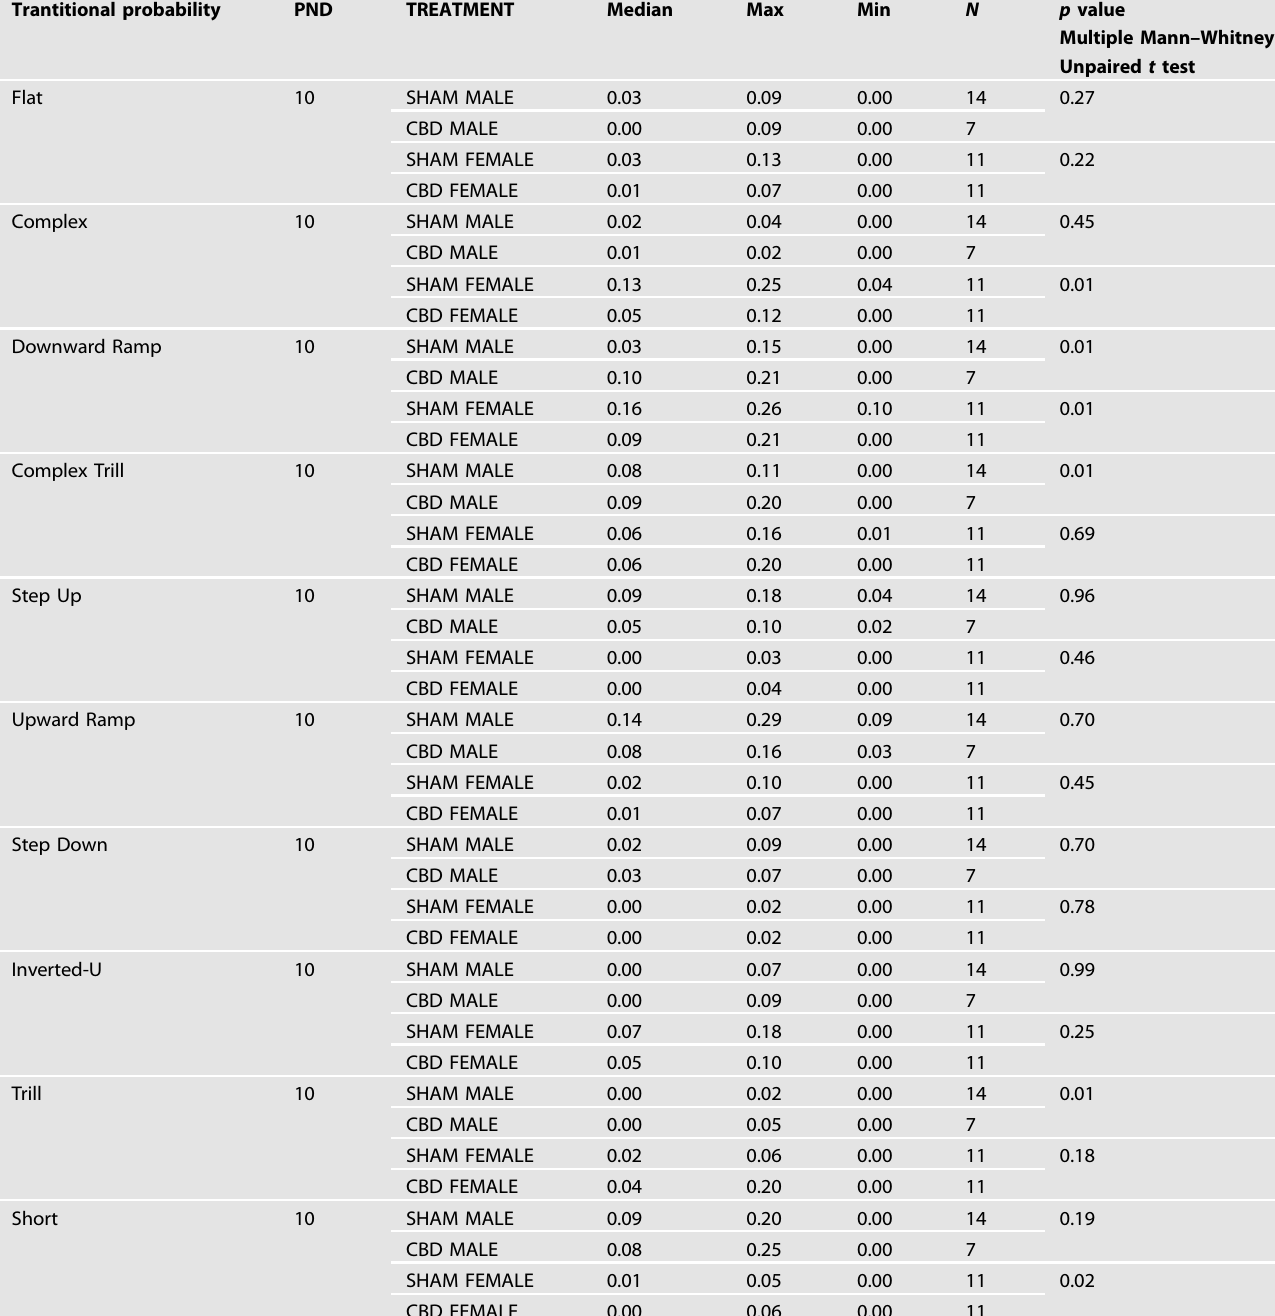
Table 4. Transitional probabilities for call type transitions within USV bouts in SHAM and CBD pups. Trantitional